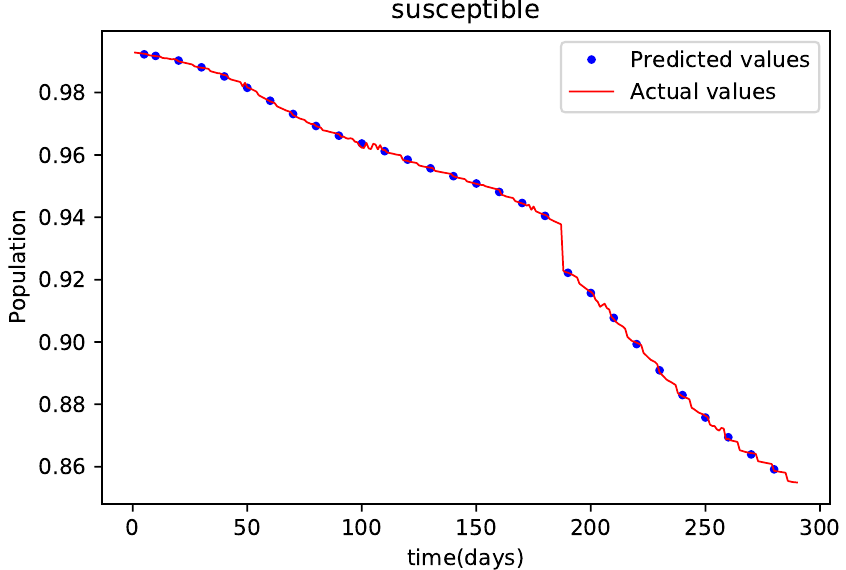
Figure 7. This graph shows a comparison of the predicted values of susceptible population and the actual data of susceptible population for the State of Alabama.